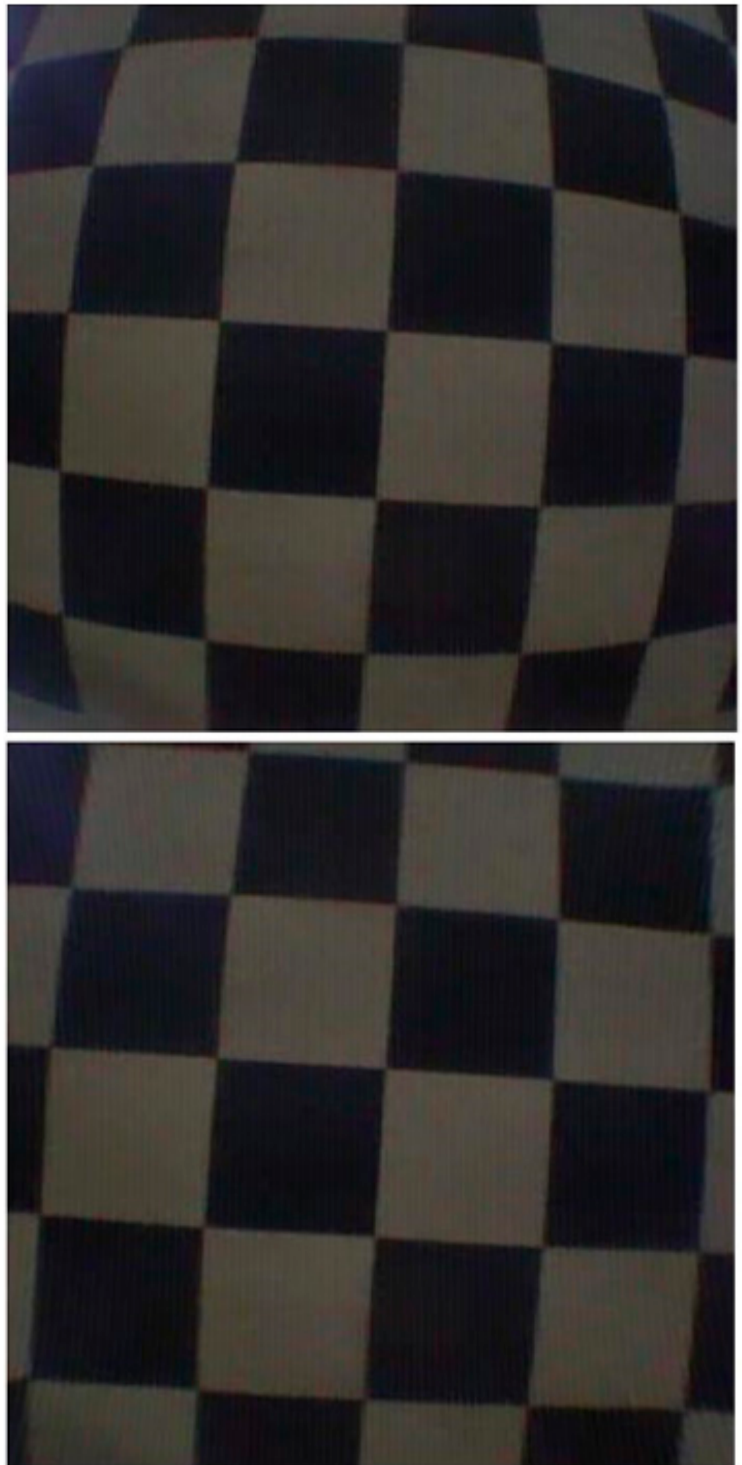
Figure 12. The original image and image after camera calibration . White balance (WB) is the process of removing incorrect color casts that affect the colors of the image; the white balance is necessary for the camera and protects the image from the saturation of light and affects. The unwanted color refers to the coolness of white light or a relative warmth.